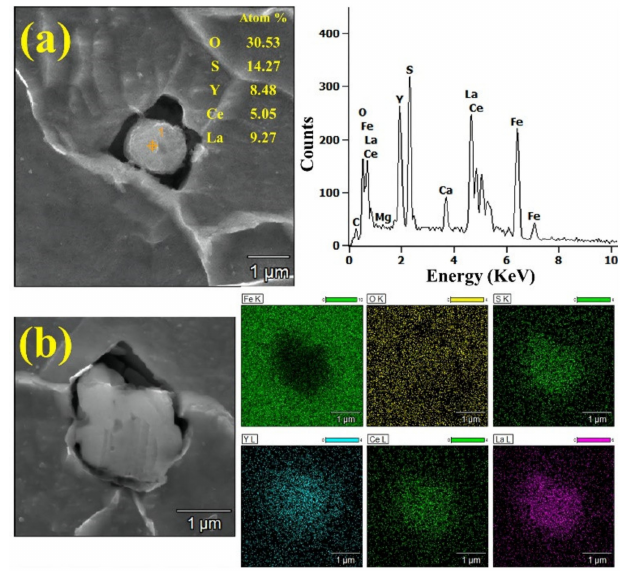
Figure 4. Morphology and type of ( a , b ) inclusions formed in 200RE steel.